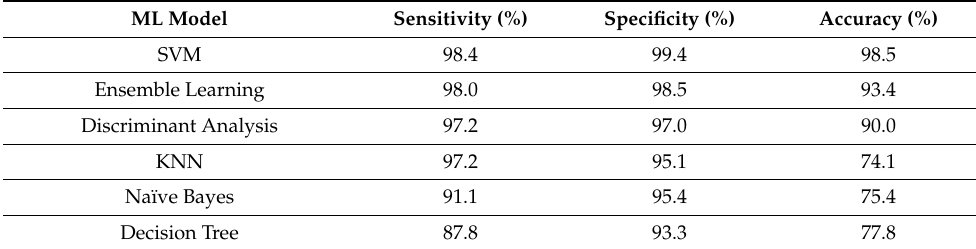
Table 4. Results of the three-class classification approach (validation).